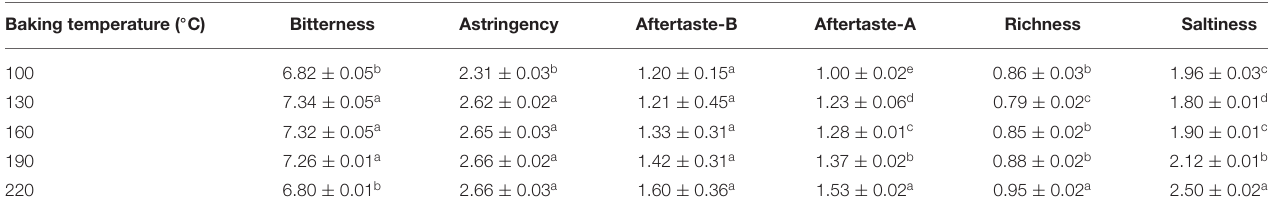
TABLE 2 | Electronic-tougue analysis of eel burgers baked at various